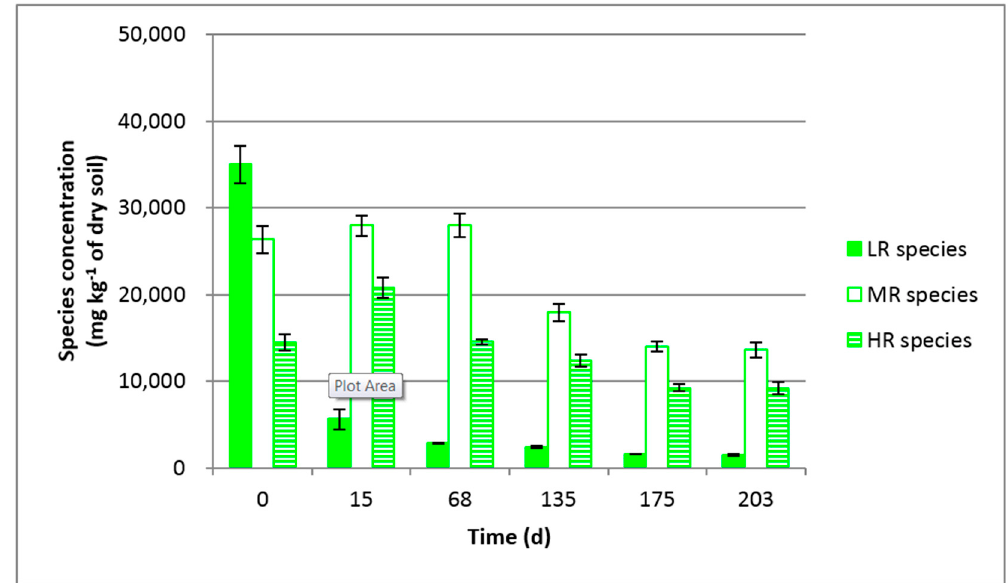
Figure 8. Change in residual diesel oil composition during the process for the BIOS-G